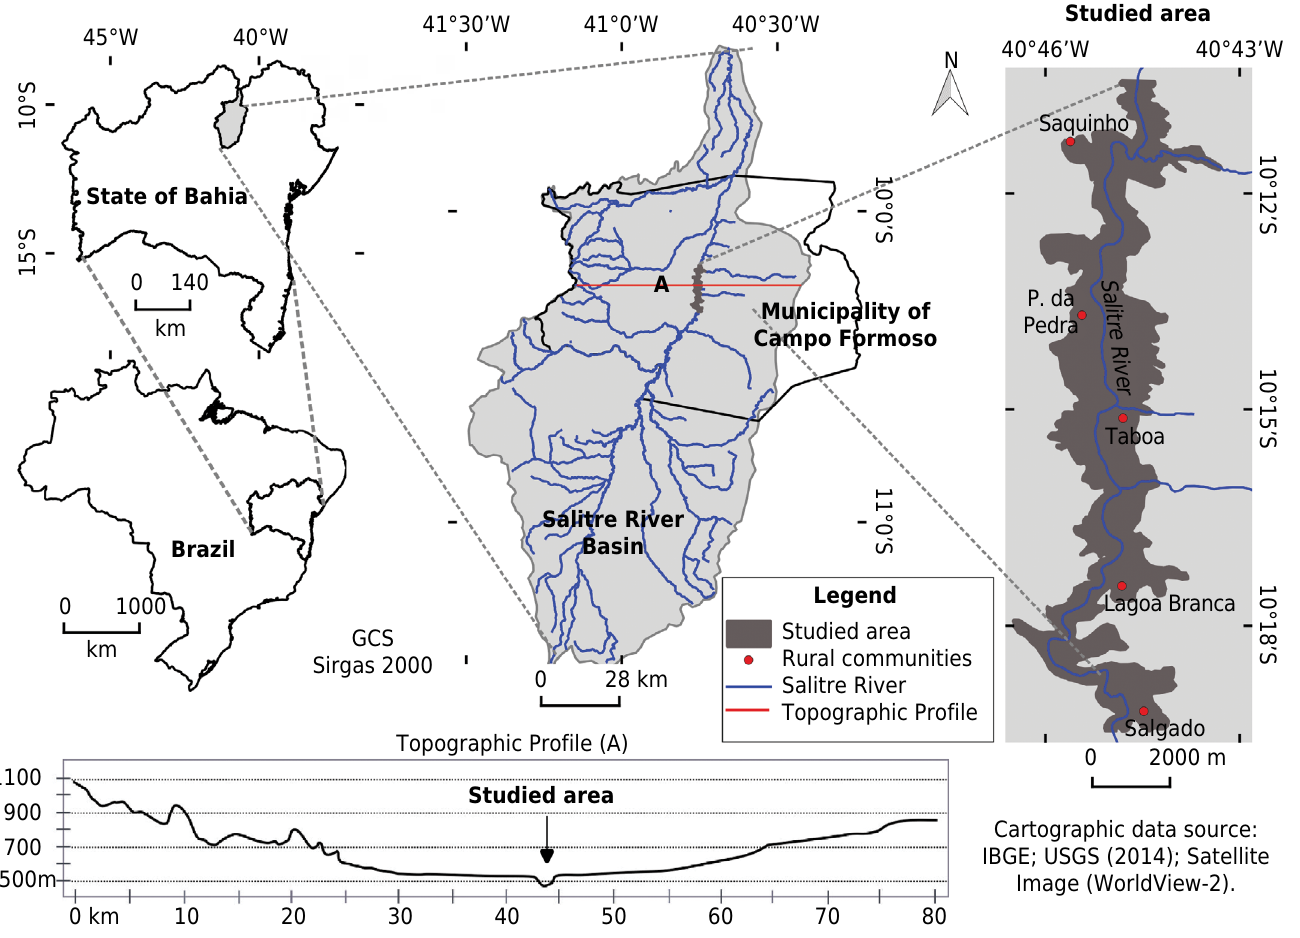
Figure 1. Location map of the studied